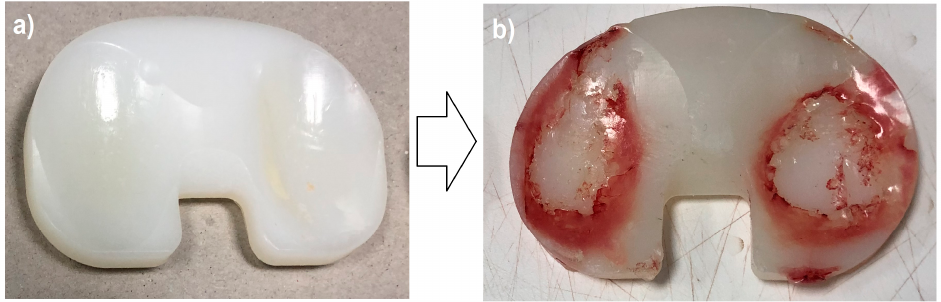
Figure 1. The UHMWPE insert for the human knee joint: ( a ) new one, ( b ) the damaged surface after several years of use.